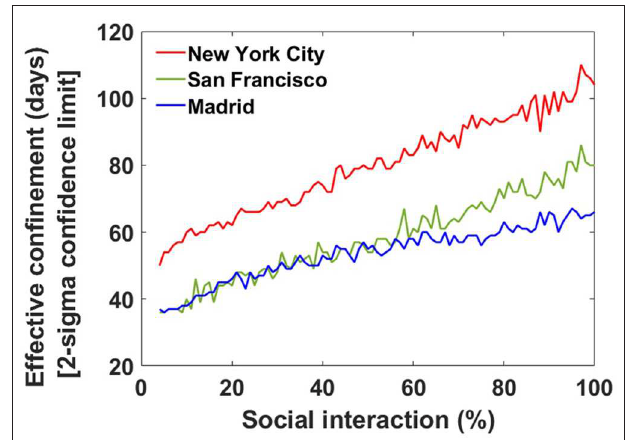
FIGURE 3 | Effective confinement days for the three cities explored as a function of social interaction (if lockdown conditions are not relaxed). The lines represent the 2-sigma upper limit, i.e., there is, at least, a 95% chance that the confinement time required to reduce the density of infected individuals below one per square kilometer is below the lines depicted. Social interaction is expressed in terms of the percentage of the probability of infection at the beginning of the outbreak (i.e., before suppression strategies apply; note that more social interaction implies higher probability of infection). The values of the parameters of the model are provided in Table 1